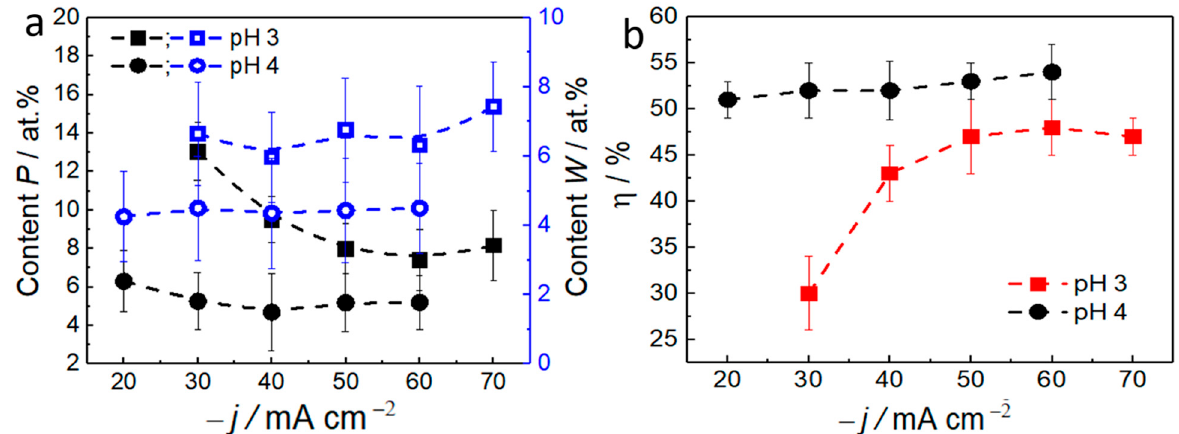
Figure 2. ( a ) Dependence of the P (black and solid) and W (blue and open) content in Fe-W-P coatings on the electrodeposition current density j at two acidic pH values. ( b ) Dependence of the current efficiency η on the electrodeposition current density j of the Fe-W-P electrodeposition at two acidic pH values.